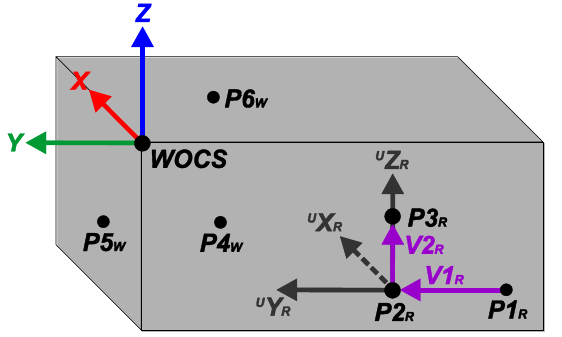
Figure 7. A general work object, showing the positions of measurements P1 - P6 , the vectors used in the positional calibration calculations and the position and rotation of the calibrated Work Object Coordinate System